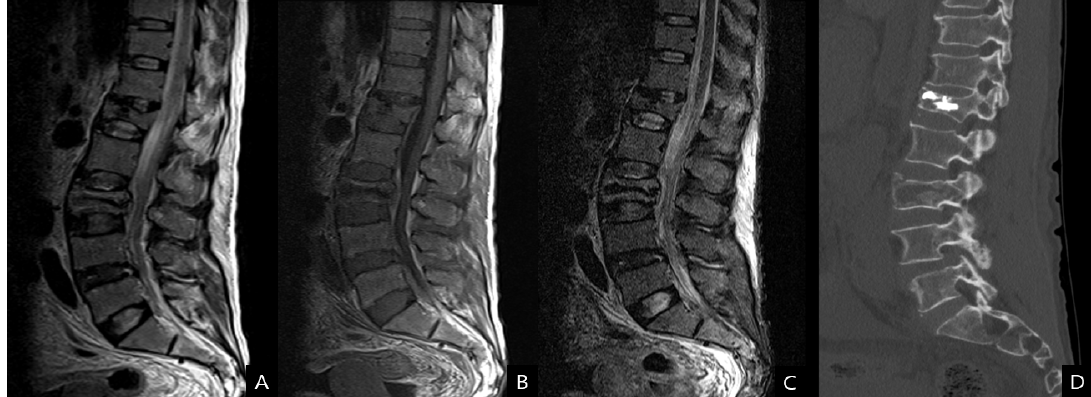
Figure 2. ( A ) T2-weighted, ( B ) T1-weighted, ( C ) short tau inversion recovery magnetic resonance images and also ( D ) computed tomography scan show a stable-type osteoporotic VCF at L3.